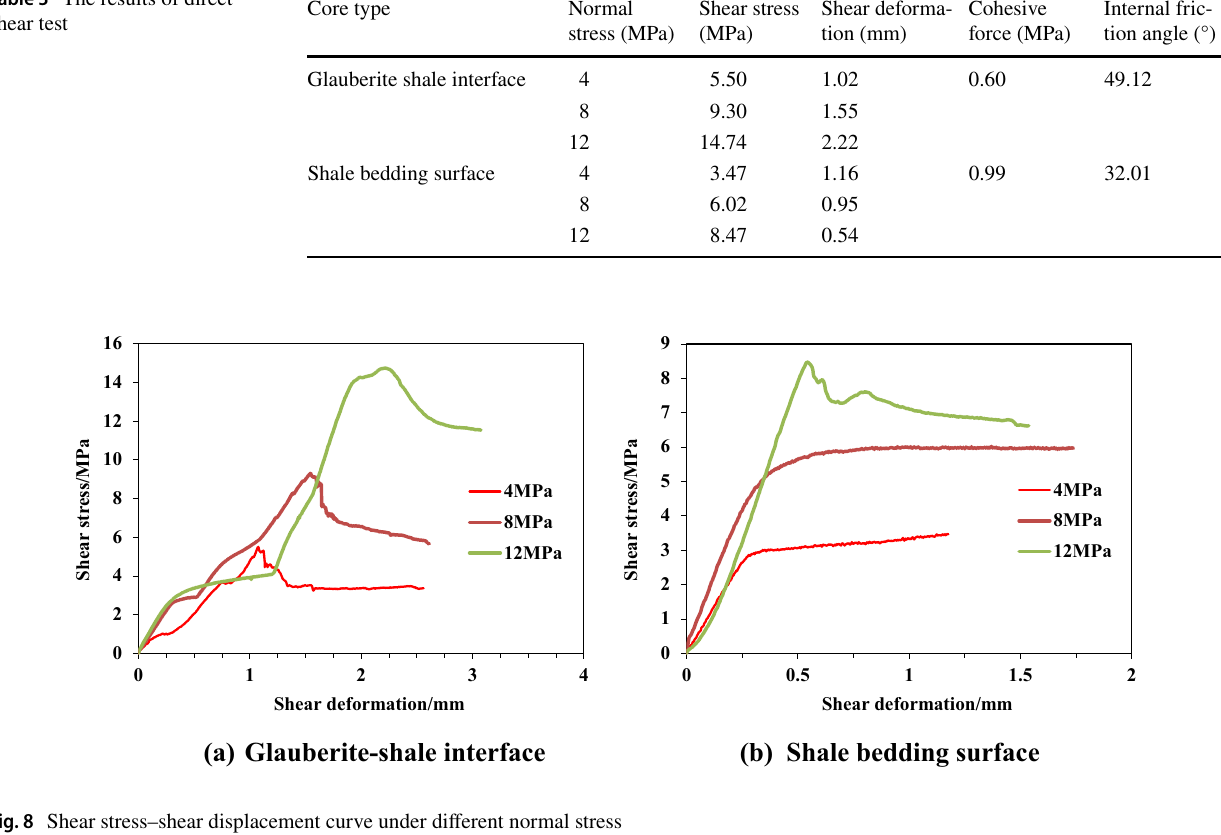
Table 3 The results of direct shear test